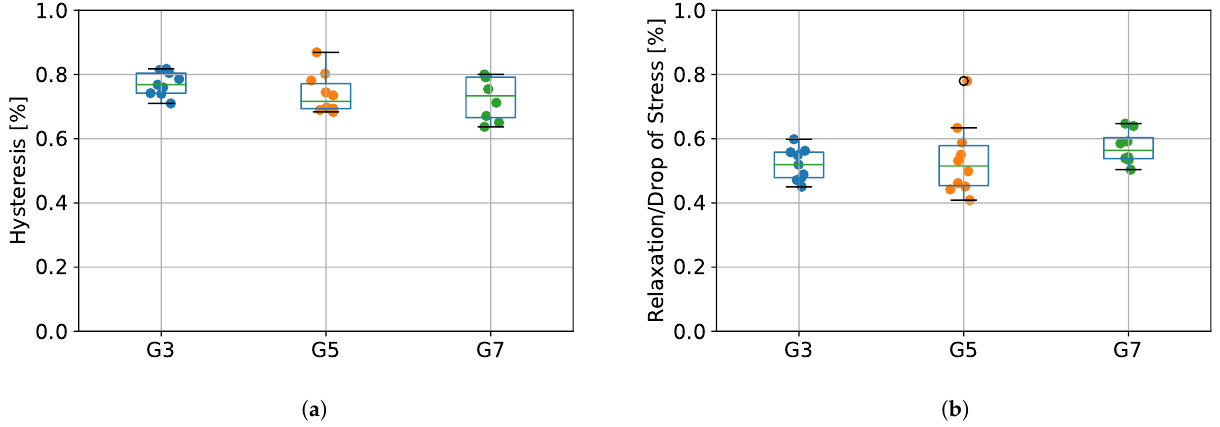
Figure 7. ( a ) The percentage of energy loss determined from the hysteresis between the first stretching and unloading, ( b ) the percentage stress drops during relaxation. G3 group refers to porcine CDET samples, G5 refers to bovine SDFT samples, and G7 refers to deer SDFT